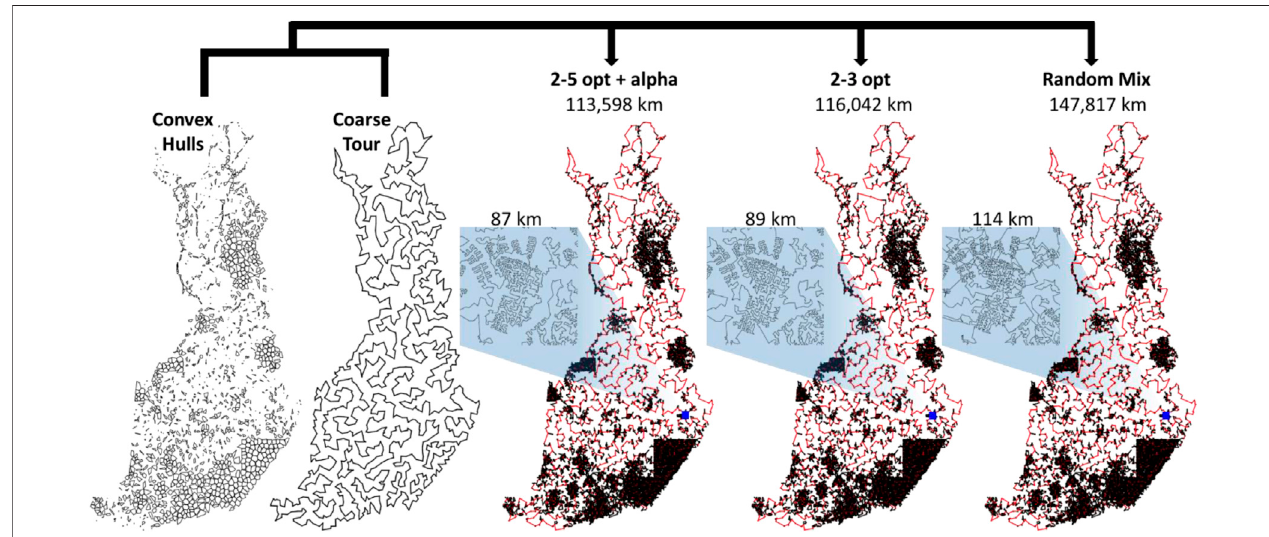
FIGURE 17 | Results when applying 3 different local search strategies when optimizing the same set of clusters and merging along the same coarse tour. The between-cluster connections are shown in